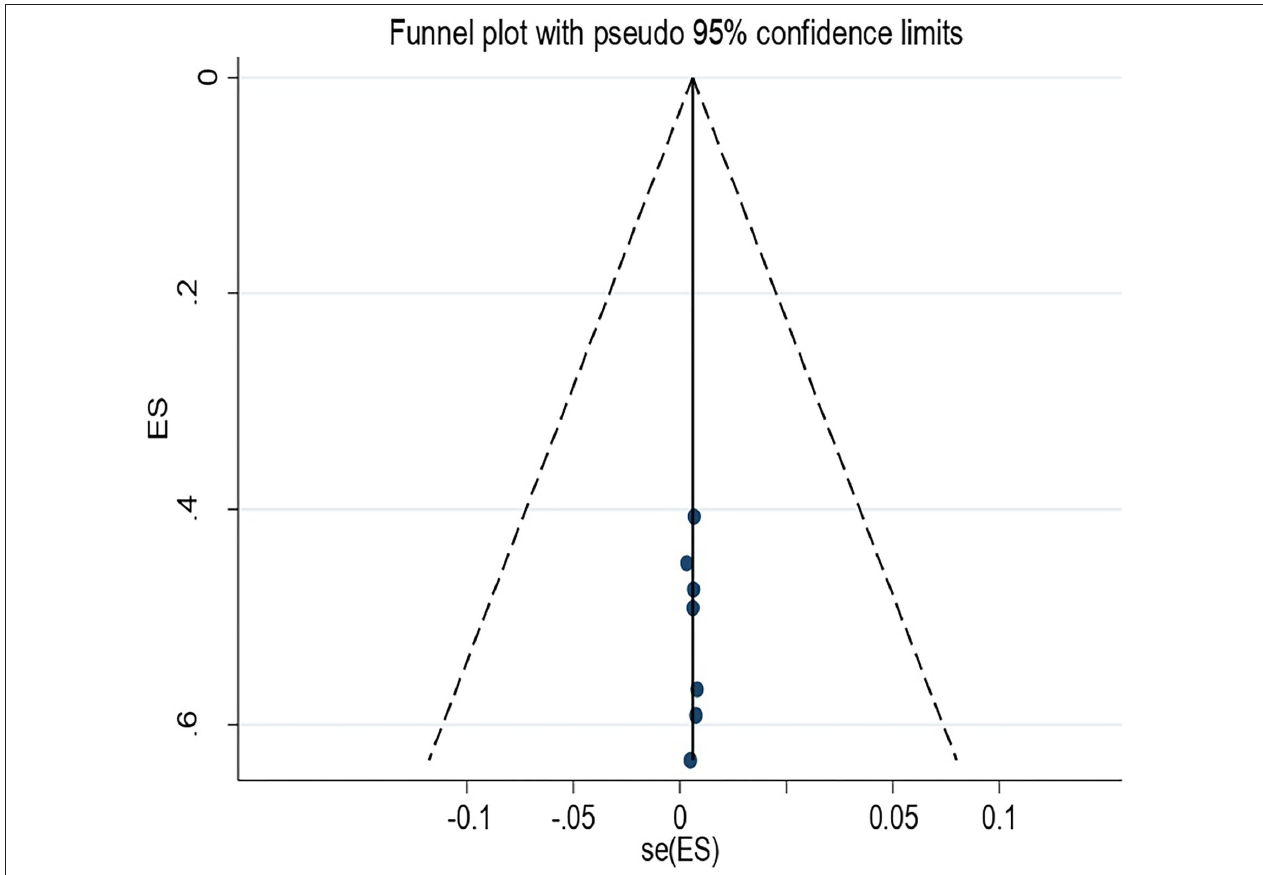
FIGURE 5 | Funnel plot for vertical transmission of Group B streptococcus among pregnant women in Ethiopia 2022.